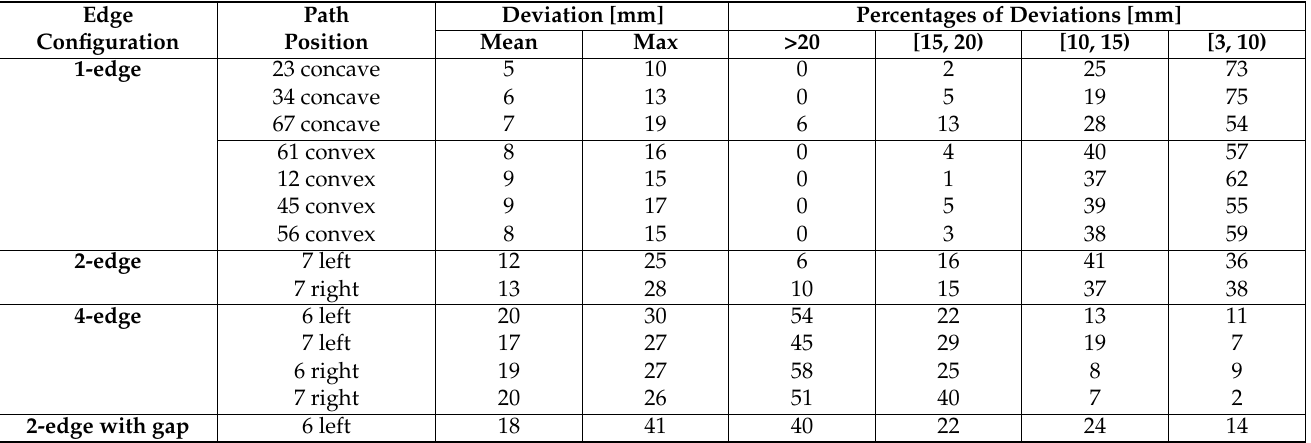
Table 1. Mean, maximum and interval deviations for each edge